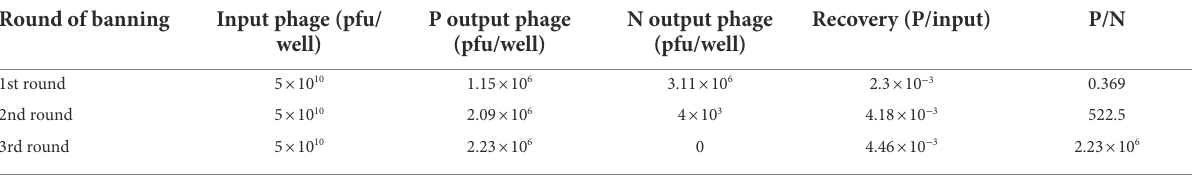
TABLE 2 Enrichment of phage particles carrying NDV-NP-specific Nbs. Round of